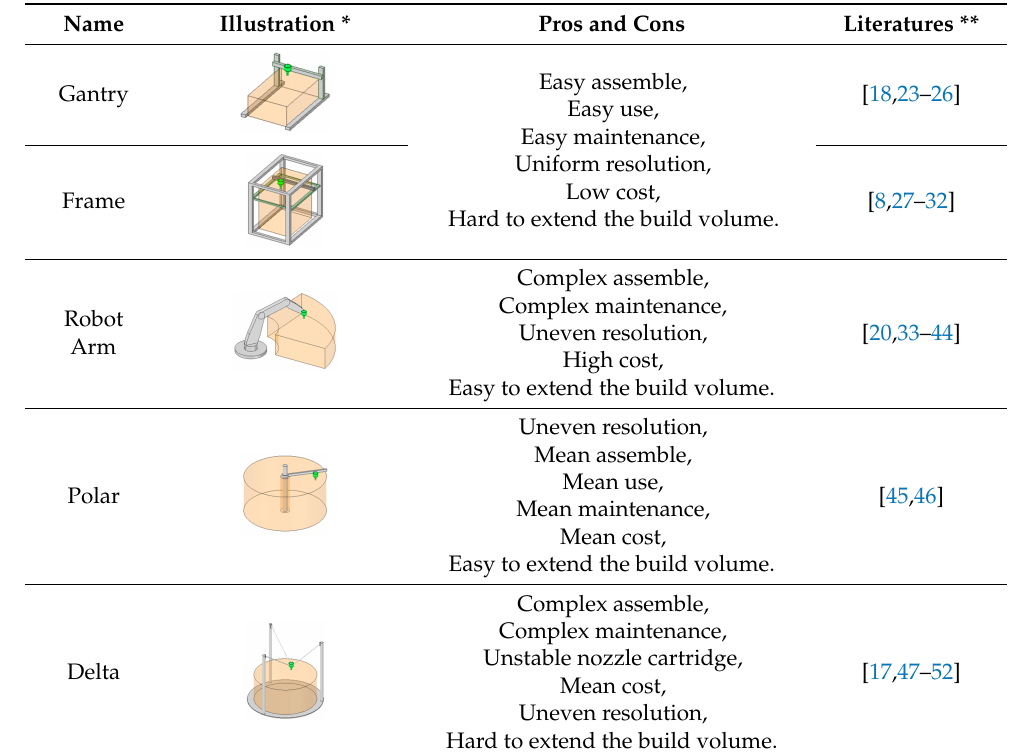
Table 1. Existing motion systems for 3DCPT.